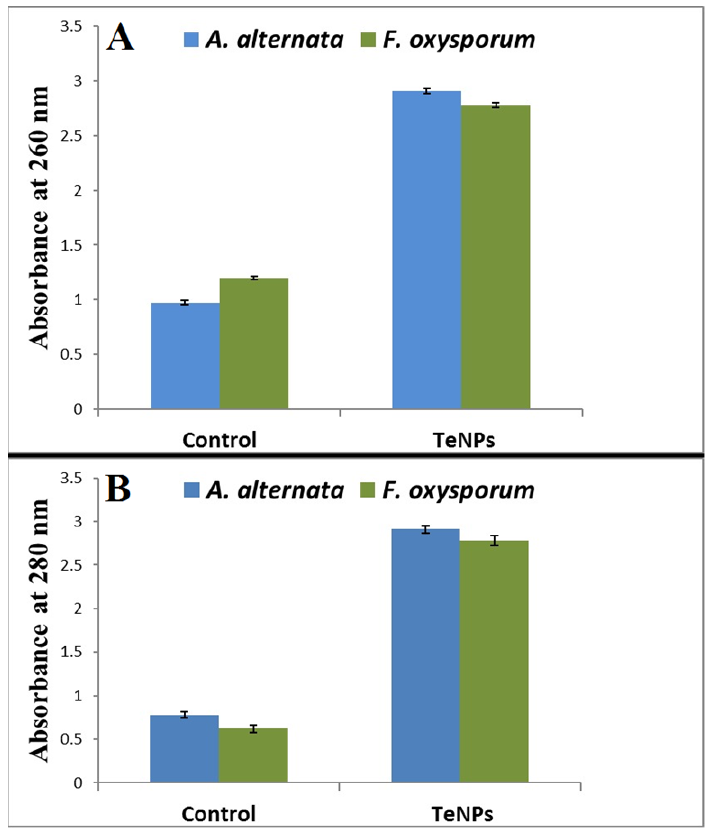
Figure 11. Effect of the biogenic TeNPs produced by Gayadomonas sp. TNPM15. on the leakage of proteins ( A ) and DNA ( B ) from spore suspension of F. oxysporum and A. alternata .